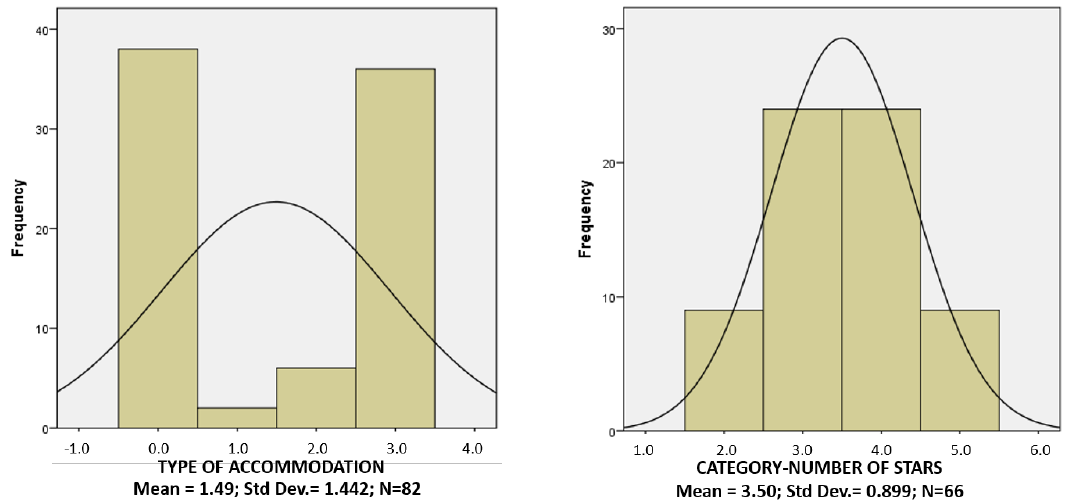
Figure 2. Types and categories of accommodation in the south of Tenerife.